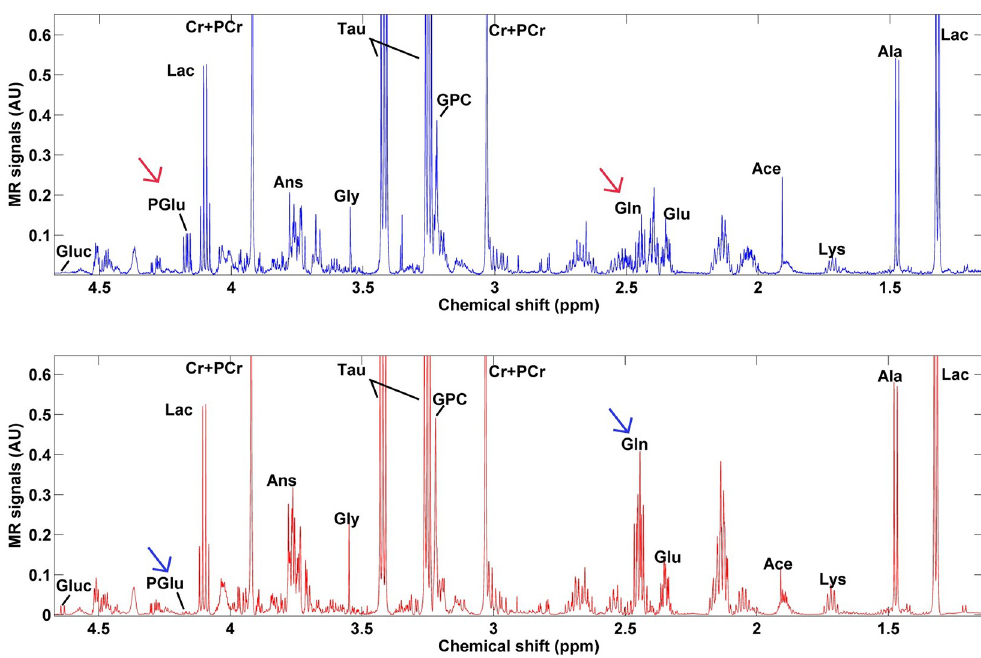
Fig 2. Proton MR spectra in soleus muscle from sedentary rats at 9 months of age. Spectra in figure show mean values of all measurements in either group. Upper panel: HCR; Lower panel LCR. Metabolite labeling: Lac, lactate; Ala, alanine; Lys, lysine; Ace, acetate; Glu, glutamate; Gln, glutamine; Cr, creatine; PCr, phosphocreatine; GPC, glycerophosphocholine; Tau, taurine; Gly, glycine; Ans, anserine. Fumarate was also identified on the spectrum and included in all further analyses, but not in the figure because of its large distance to the other peaks. Note significant differences in PGlu and Gln and marked by arrows.